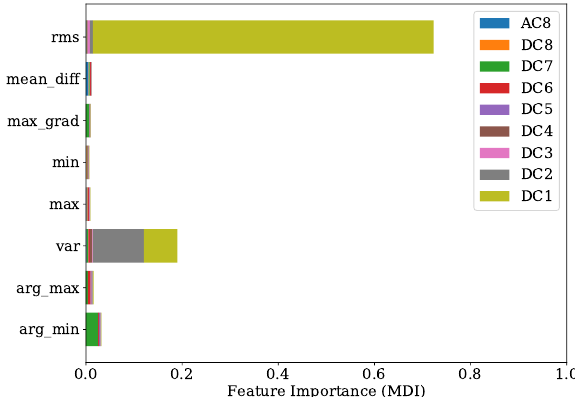
Figure 13. FI of PFP regression with regard to training set of engine 1.